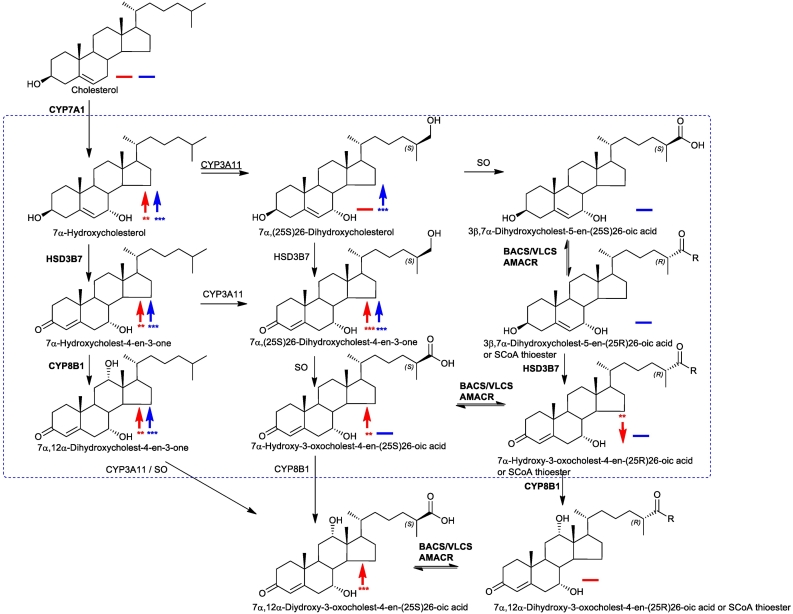
Additional routes for cholesterol metabolism in the Cyp27a1−/− mouse. R = H in acids or SCoA in CoA thioesters. Where known enzymes are indicated in bold. CYP3A11 was found in the present work to introduce a (25S)26-hydroxy group to 7α-hydroxycholesterol as indicated by underlining of the enzyme symbol. The enzyme which converts the (25S)26-primary alcohol to a carboxylic acid is indicated as a sterol oxidase (SO). Metabolites of increased or decreased abundance in the Cyp27a1−/− mouse are indicated by upward or downward arrow. Red arrows are used to indicate changes in plasma, blue arrows for brain. A horizontal solid line indicates detected but not changed significantly. *, P < 0.05; ** P < 0.01; *** P < 0.001. P < 0.05 is considered significant. The low levels of di- and tri-hydroxycholesterols and of dihydroxycholestenoic acids in brain makes it difficult to distinguish between these compounds and their 3-oxo equivalents using EADSA as their differentiation is based on peak area difference between samples treated with and without cholesterol oxidase. Hence, for these metabolites the combined values for the two structures are considered. The metabolites identified in brain are enclosed within the blue box. Abbreviations are as in Fig. 1.